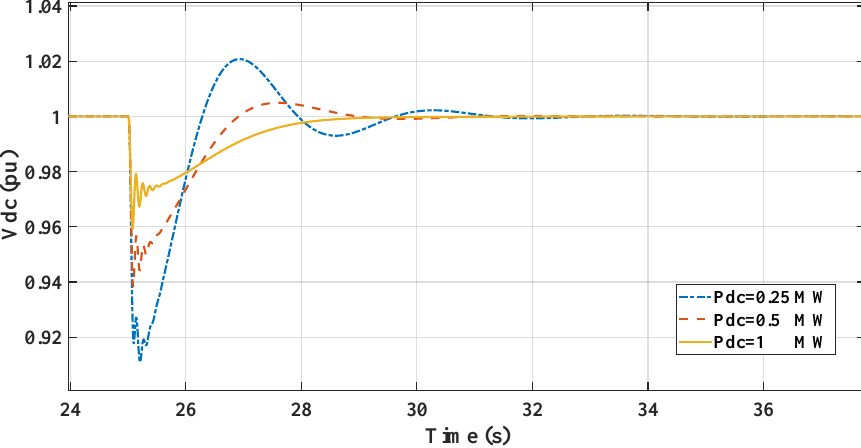
Figure 18. DC bus voltage at different DC-microgrid loadings.